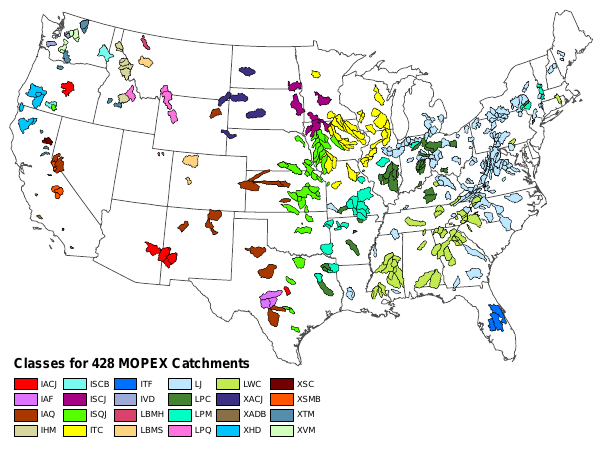
Fig. 13. All classes.